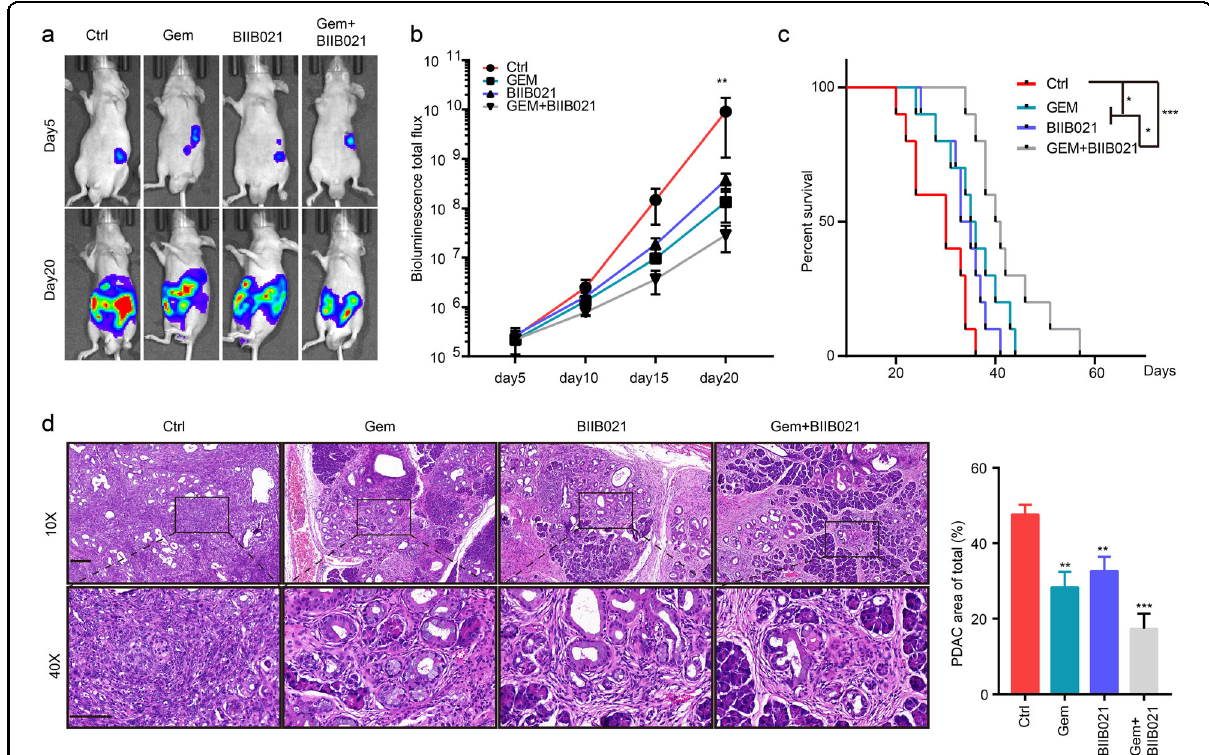
Fig. 4 HSP90 inhibition suppress the progression of PDAC in vivo. a Representative bioluminescence photograph of mice orthotopically implanted with KPC C2 Luc cells treated with 0.9% NaCl (named ctrl), gemcitabine (50 mg/kg), BIIB021 (10 mg/kg), or gemcitabine (50 mg/kg) plus BIIB021 (10 mg/kg). b Statistics for the total bioluminescence of the orthotopic PDAC mouse model ( n = 5). c Kaplan – Meier survival plot of orthotopic PDAC mice ( n = 10 per group). d H&E staining of KPC mice treated with 0.9% NaCl (named ctrl), gemcitabine (50 mg/kg), BIIB021 (10 mg/kg), or gemcitabine (50 mg/kg) plus BIIB021 (10 mg/kg). Scale bar, 50 μ m. The statistical results of the PDAC area are shown in the right panel ( n =